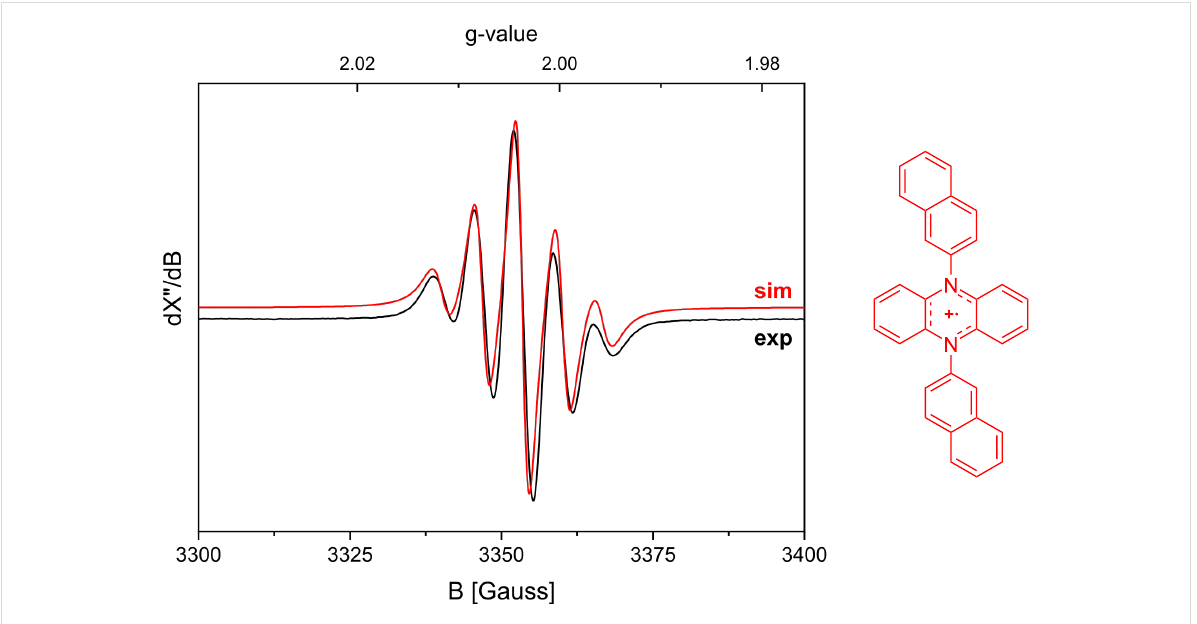
Figure 3: EPR spectra measured (black) and simulated (red) based on the structure of the oxidized photoredox catalyst shown on the right.